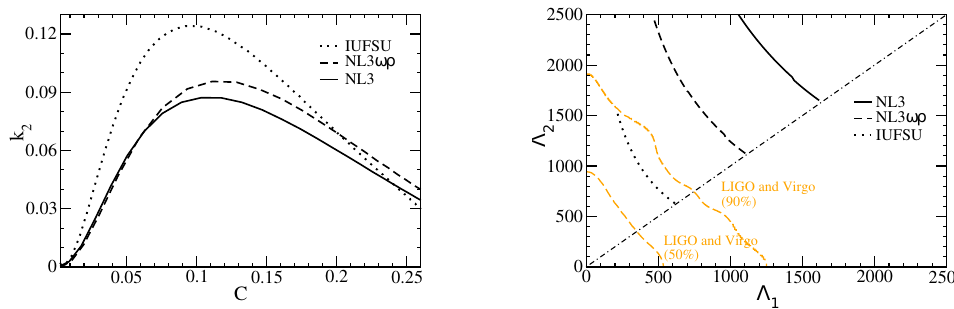
Figure 13. ( Left ) Love number as a function of the compactness and ( Right ) tidal deformabilities of both NS in the binary system before the